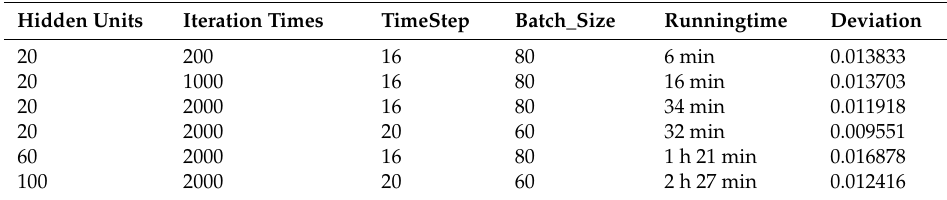
Table 2. Results of six different situations.